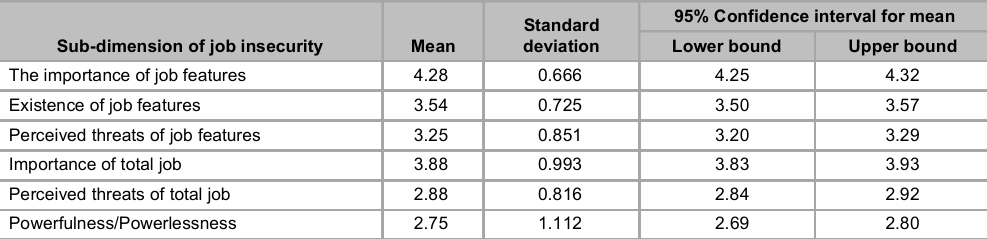
Descriptive statistics: sub-dimensions of job